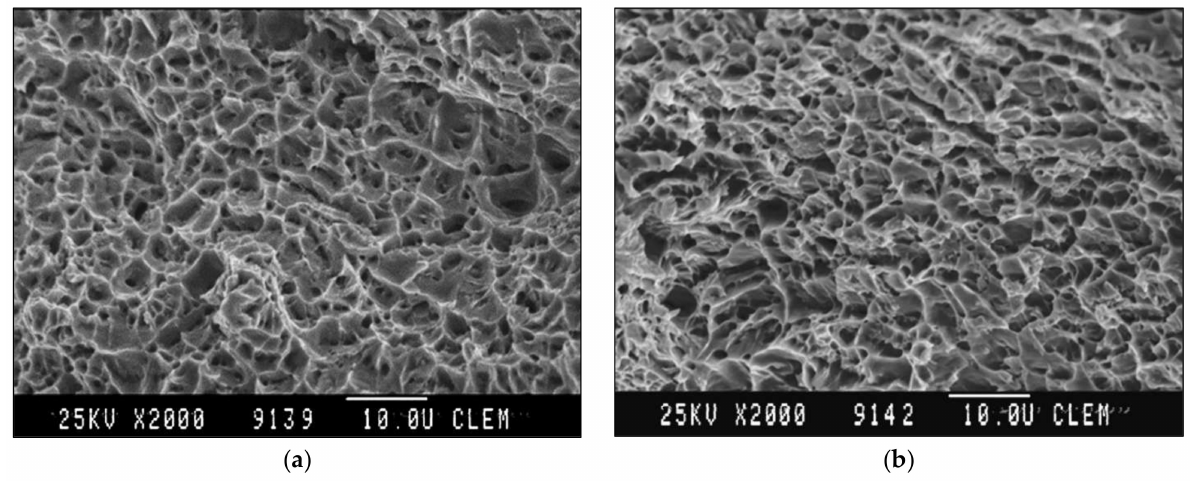
Figure 10. Fracture surface of DP600 steel: ( a ) under static loading 8.33 × 10 − 3 s − 1 , ( b ) under dynamic loading 1200 s − 1